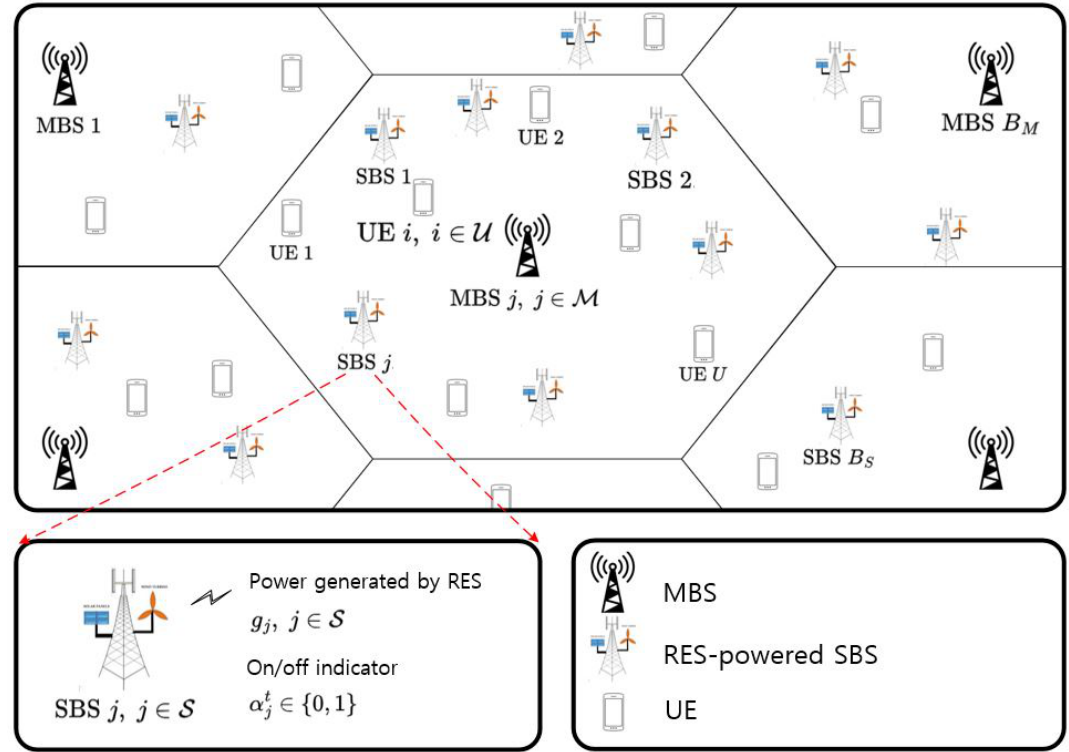
Figure 1. Network deployment with RES-powered